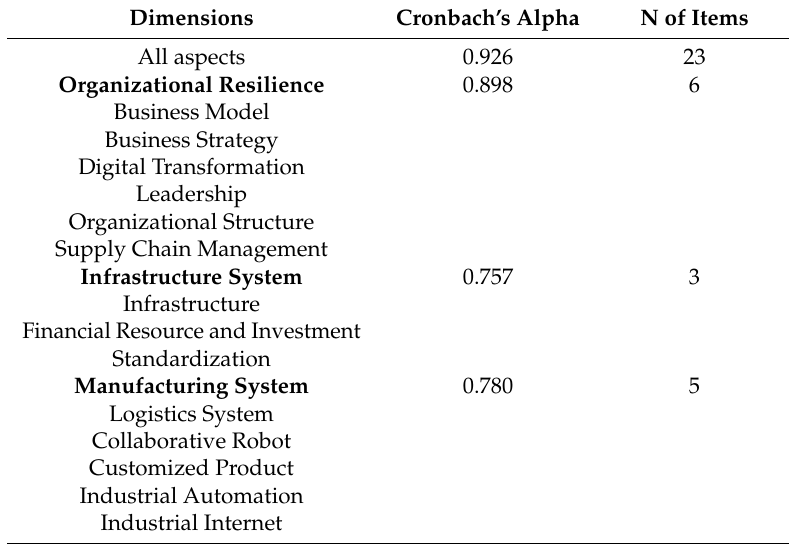
Table 6. Data reliability